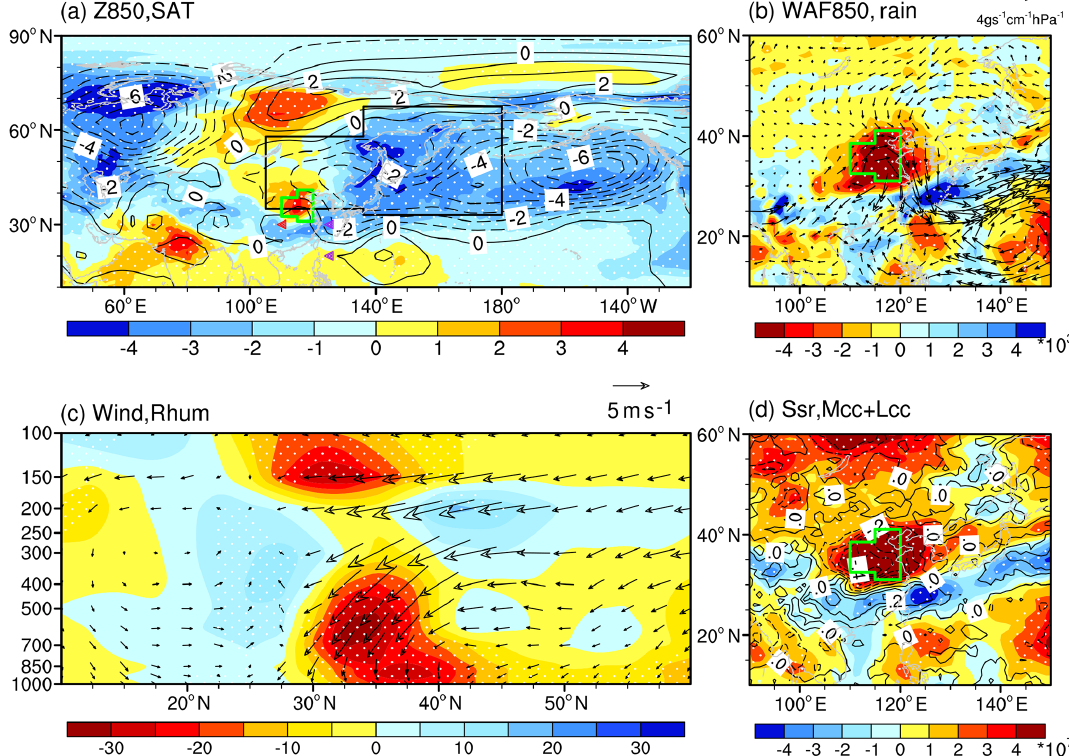
Figure 6. Differences of the daytime atmospheric circulations (i.e., PAT1P minus PAT1N): (a) geopotential height at 850hPa (unit: 10gpm, contours) and surface air temperature (unit: K, shading), (b) water vapor flux (unit: gs − 1 cm − 1 hPa − 1 ) at 850hPa (arrows) and precipitation (unit: mm, shading), (c) 100–120 ◦ E mean wind (unit: ms − 1 , arrows) and relative humidity (unit: %, shading), and (d) downward solar radiation at the surface (unit: 10 7 Jm − 2 , shading) and the sum of low and medium cloud cover (unit: 1, contours). The white dots indicate that the shading was above the 95% confidence level. The green boxes in panels (a) , (b) and (d) show the NCH region, and the black box in panel (a) indicates the location of the East Asian trough. The purple triangles in panel (a) indicate the data used to calculate the WPSH 1 , while the red triangle represents the western ridge point of